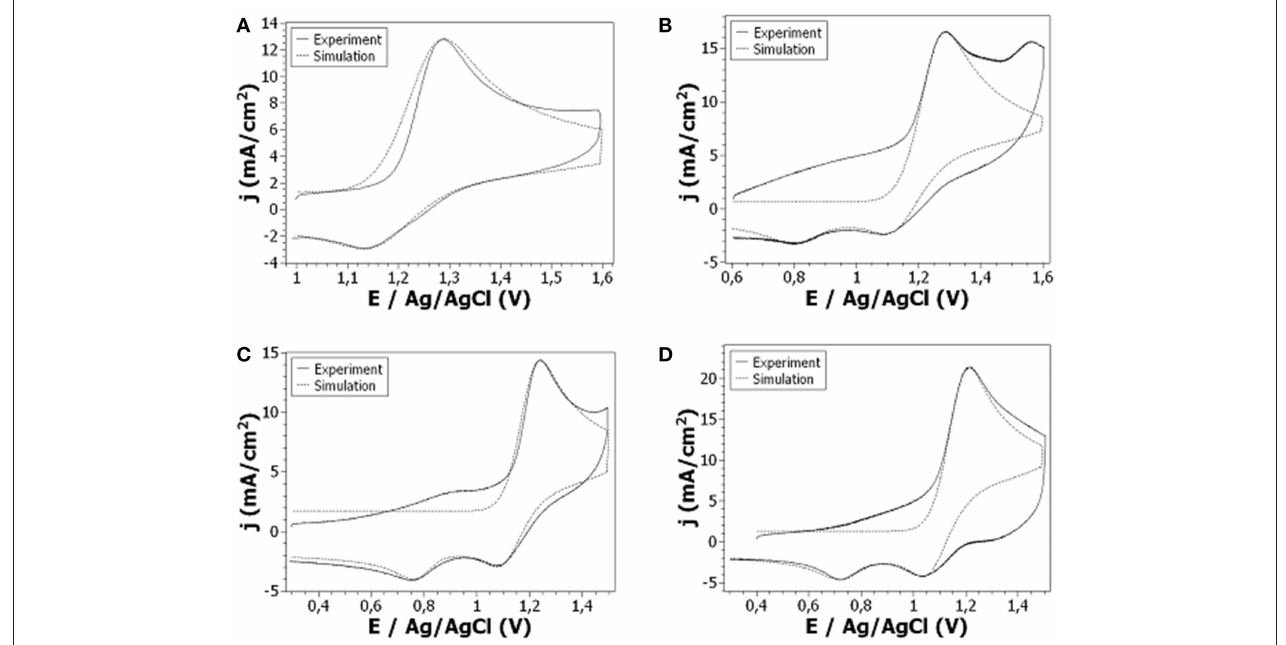
FIGURE 7 | Cyclic voltammetry at a Pt electrode of 10 − 2 M: (A) Cz1Me, (B) Cz3Me, (C) Cz5Me, (D) Cz7Me + 0.1M LiClO 4 in ACN. Scan rate: 100 V/s.